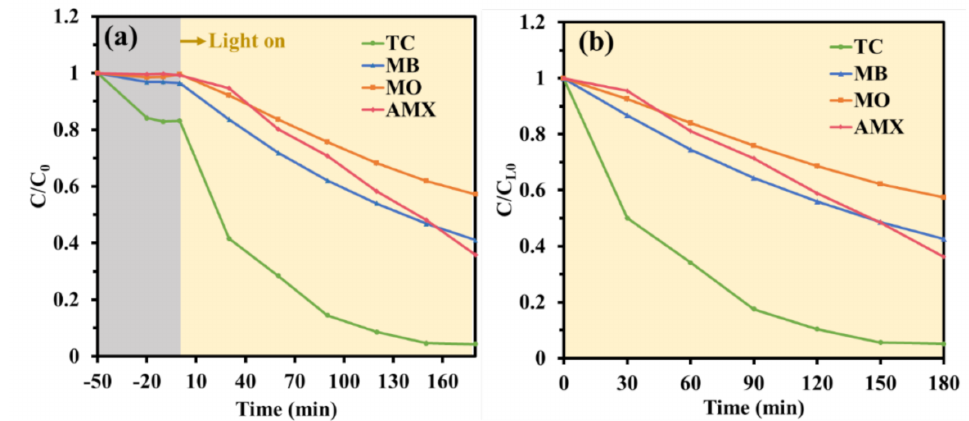
Figure 9. The changes of ( a ) C/C 0 and ( b ) C/C L0 with the reaction time by using ZnTiO 3 -700 ◦ C to degrade TC, MB, MO, and AMX.